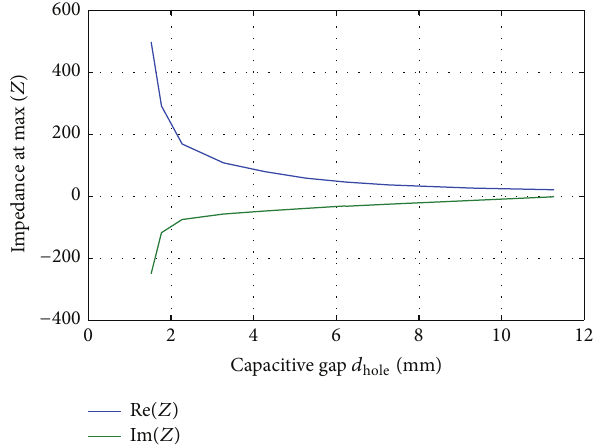
Figure 6: Impact of capacitive gap 𝑑 the antenna.